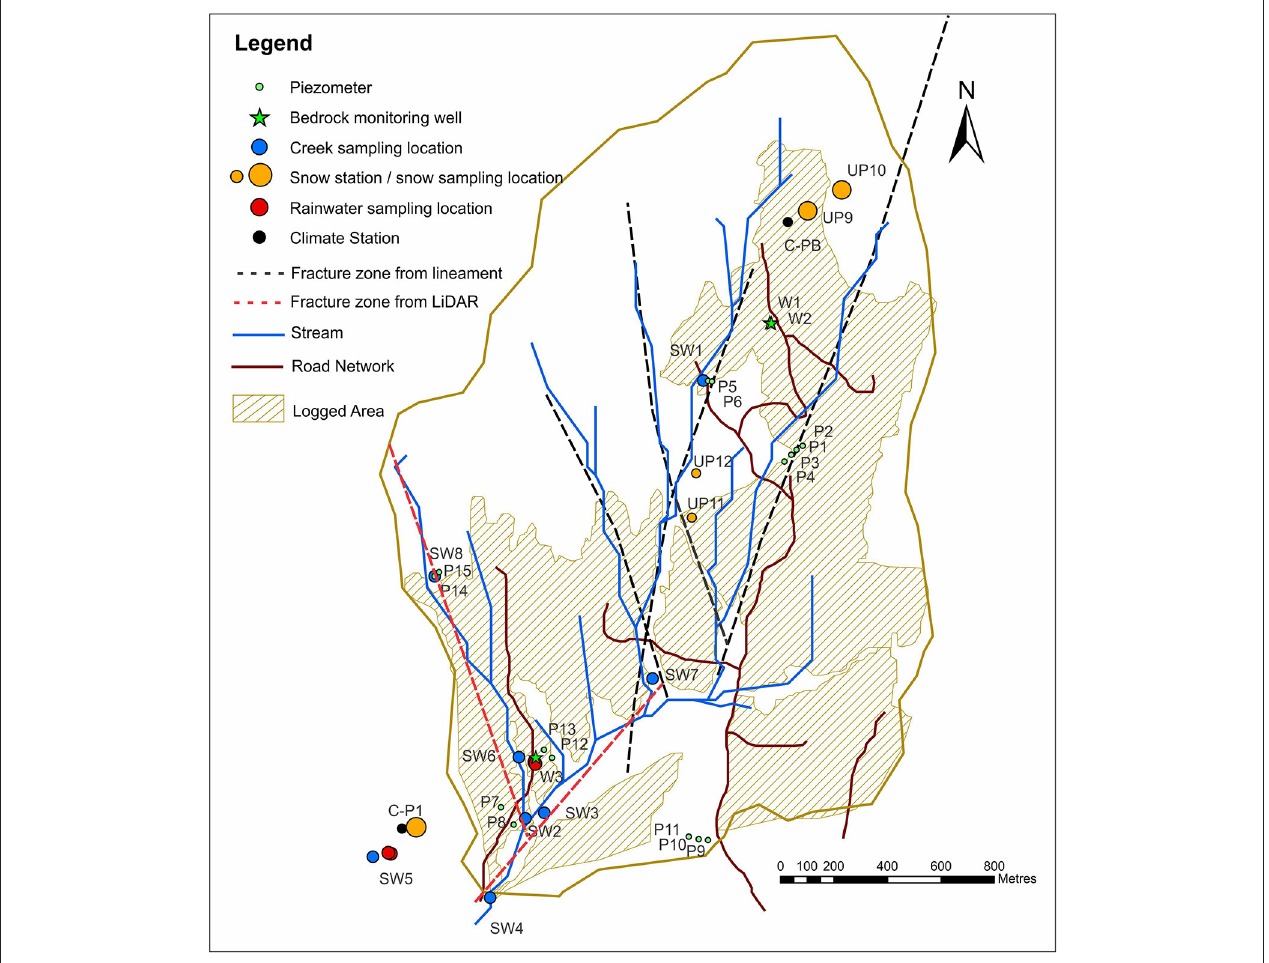
FIGURE 2 | UPC catchment showing climate stations, snow stations, stream network, soil piezometers and groundwater wells where both physical water measurements were made as well as samples collected for water chemistry and stable isotope analysis. Logged areas shown in hatched brown. Also shown are presumed fracture zones mapped from lineaments (black dashed lines) and from the LiDAR-derived DEM hillshade (red dashed